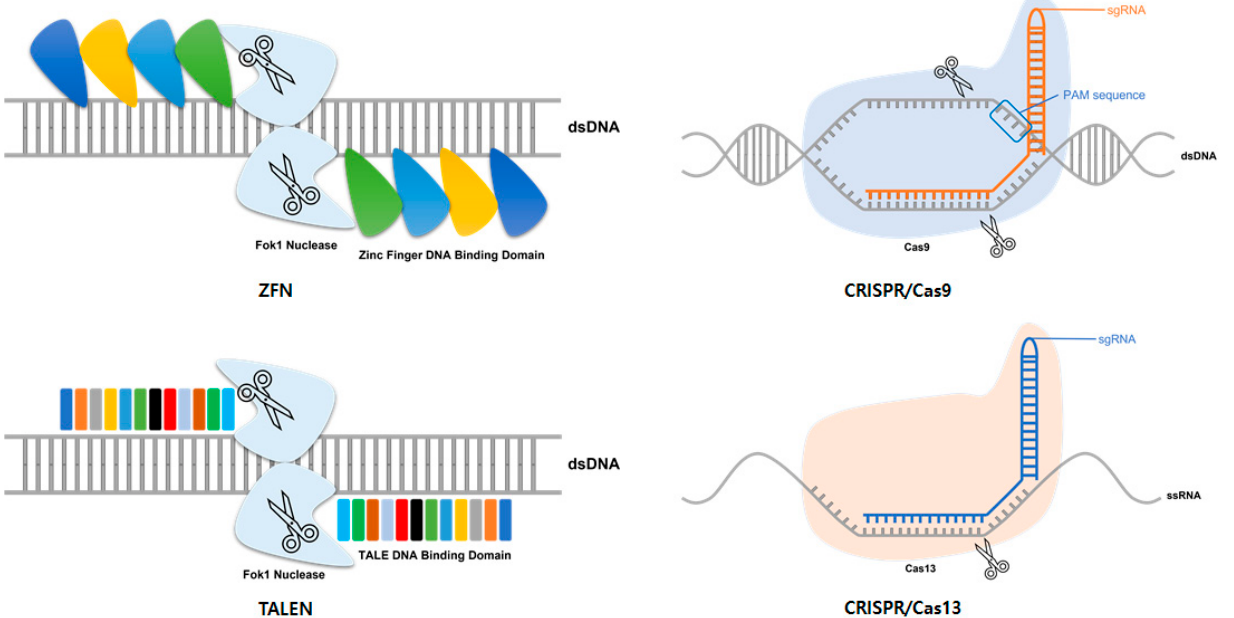
Figure 1. Platforms used for genome editing. Representative tools for genome editing include zinc- finger nucleases (ZFN), transcription activator-like effector nucleases (TALEN), and the clustered regularly interspaced short palindromic repeats (CRISPR)-CRISPR-associated (Cas) system. ZFN is composed of a collection of many zinc-finger DNA binding motifs and a Fok1 endonuclease domain. TALEN is composed of a combination of a DNA binding domain, called TALE, and a Fok1 endo- nuclease domain. In general, the CRISPR/Cas system is an RNA-guided DNA-cleavage system, such as CRISPR/Cas9. CRISPR/Cas13 is an RNA-guide RNA-cleavage system. Like other CRISPR/Cas systems, it consists of gRNA and Cas protein.